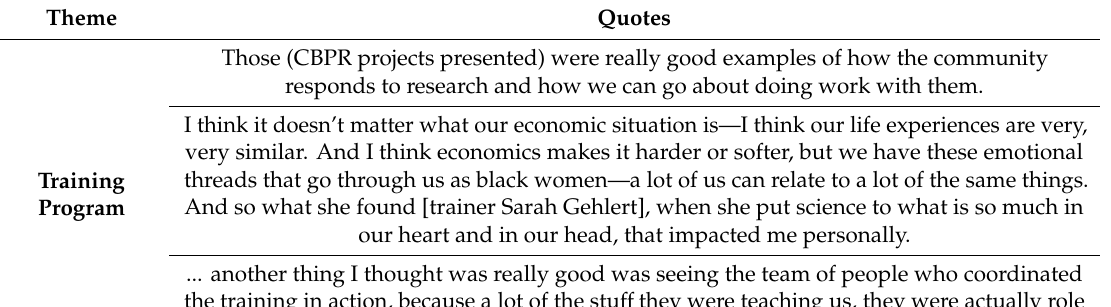
Table 4. Illustration of CRIBS fellows’ perspectives and